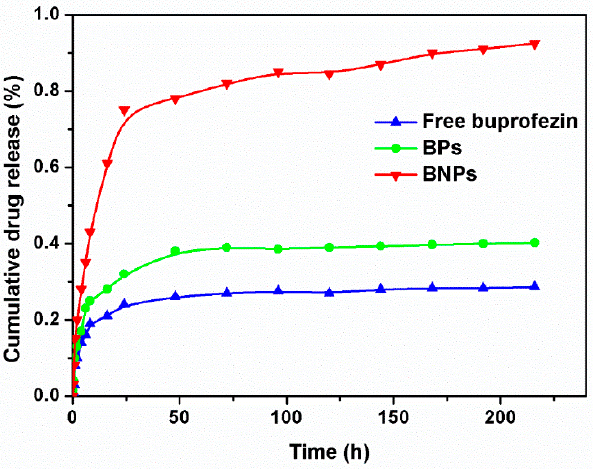
Figure 2. BNPs fabricated with AAO templates with 100 nm pore sizes in different drug concentration (5, 10, 20, 40 mg/mL) with different cycles (2, 5, 10 cycles). ( a ) DLS image of BNPs in different drug concentration (5, 10, 20, 40 mg/mL), ( b ) DLS image of BNPs with different cycles (2, 5, 10 cycles).